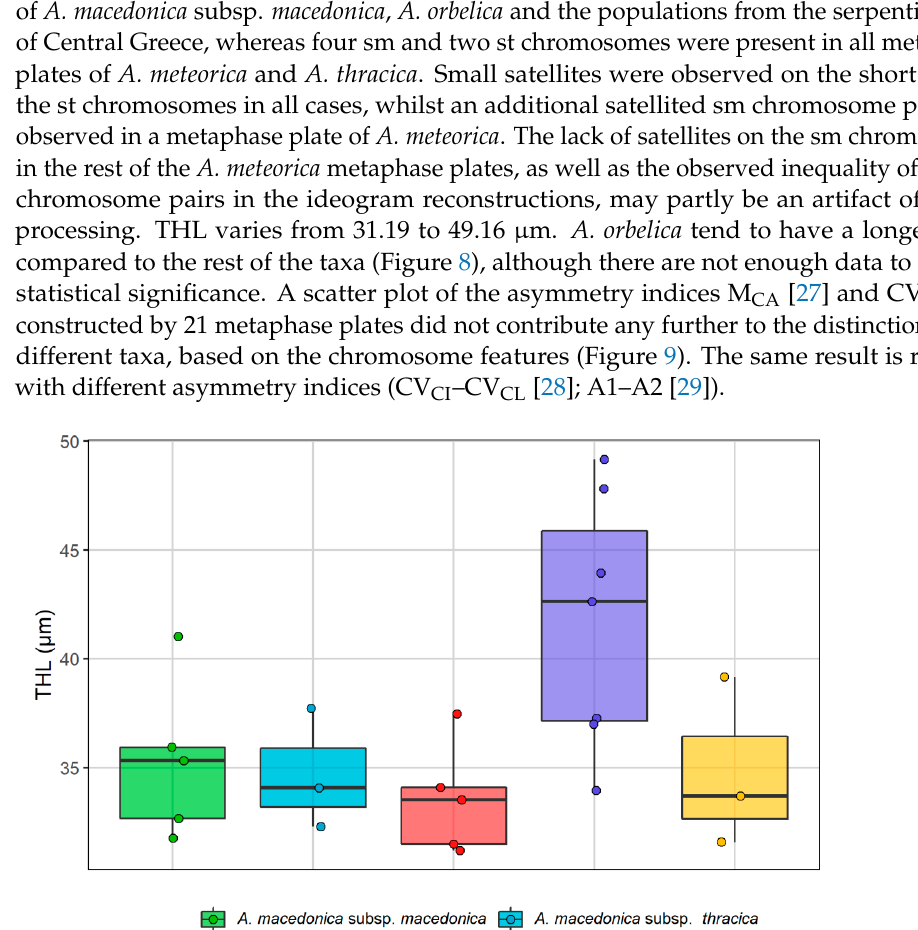
Figure 9. Scatter plot showing the karyotype indices of the intrachromosomal (M CA ) and inter- chromosomal (CV CL ) asymmetry for all the studied taxa in the Anthemis macedonica group.